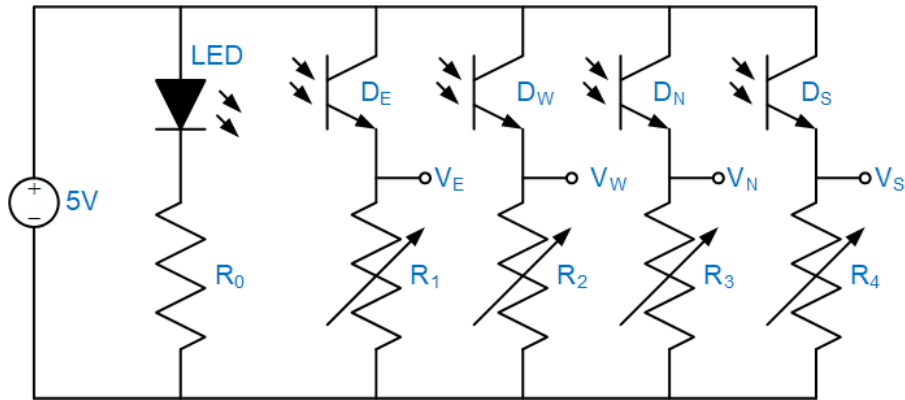
Figure 3. The schematic drawing of the sensor circuit, powered by 5 V of DC.